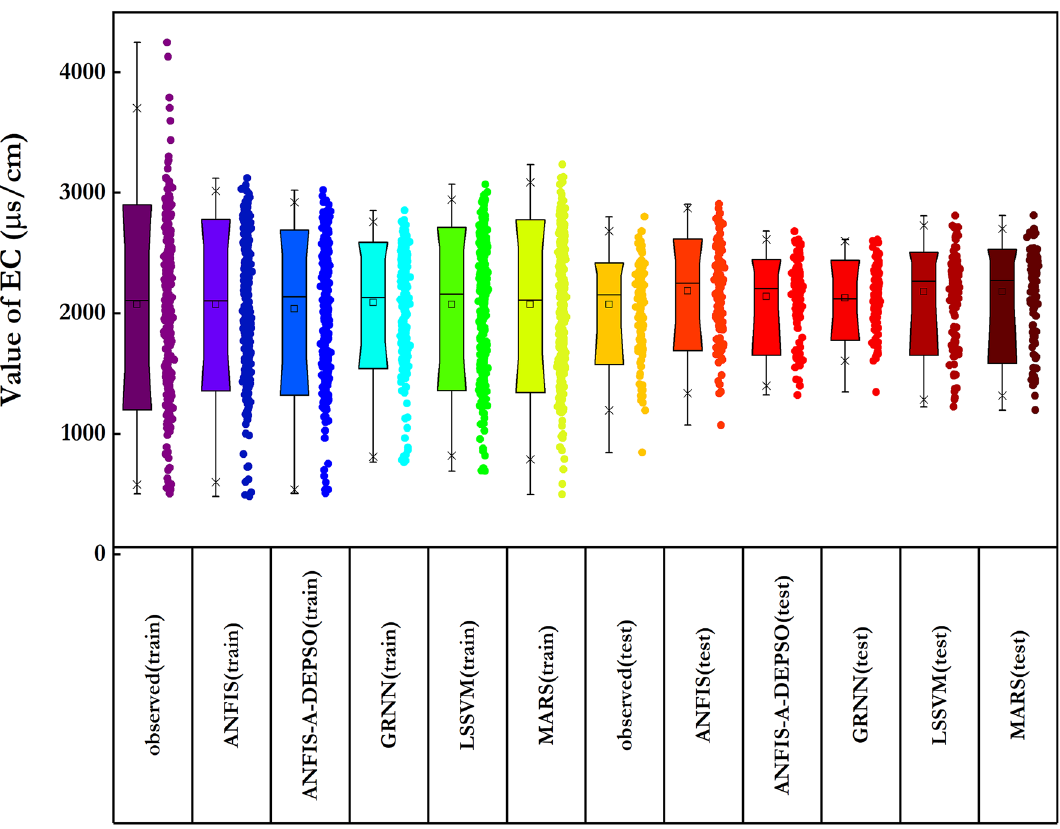
Figure 11. Assessing the distribution of estimated and measured values of EC obtained by all ML models.